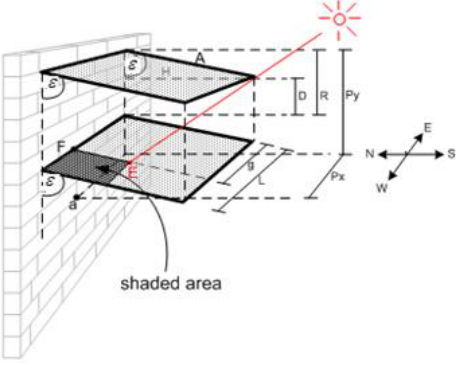
Figure 9. Shadow of an inclined pole on a horizontal plate.